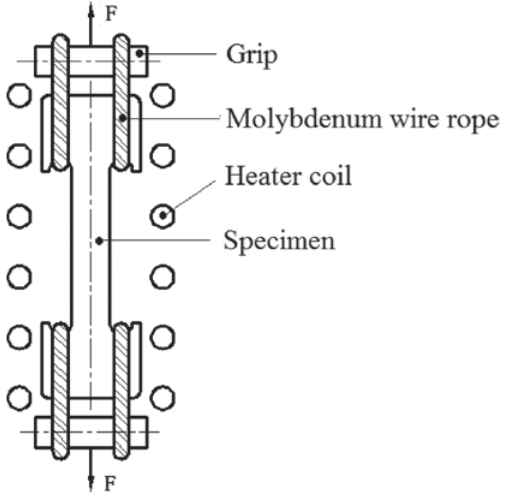
Fig. 2: Device for tension